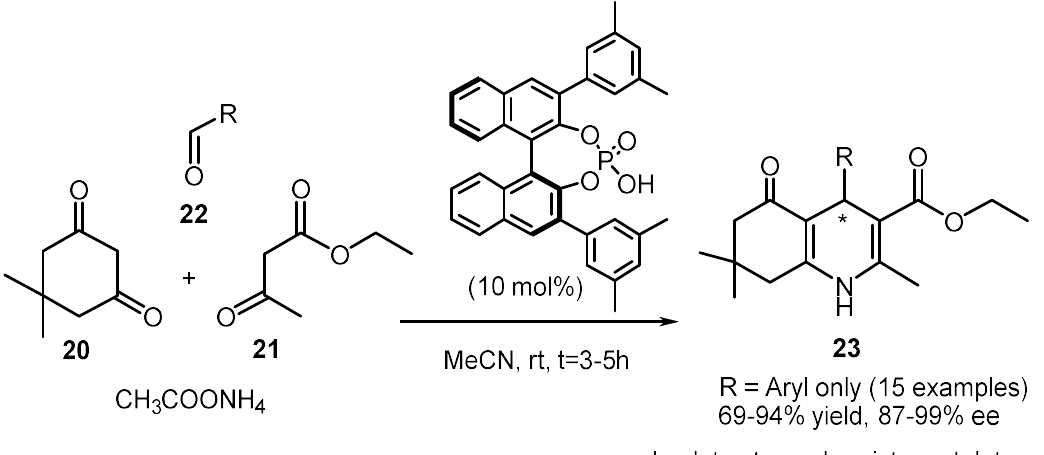
Scheme 5. Chiral BINOL-derived phosphoric acid catalysed synthesis of bicyclic 1,4-DHP 23